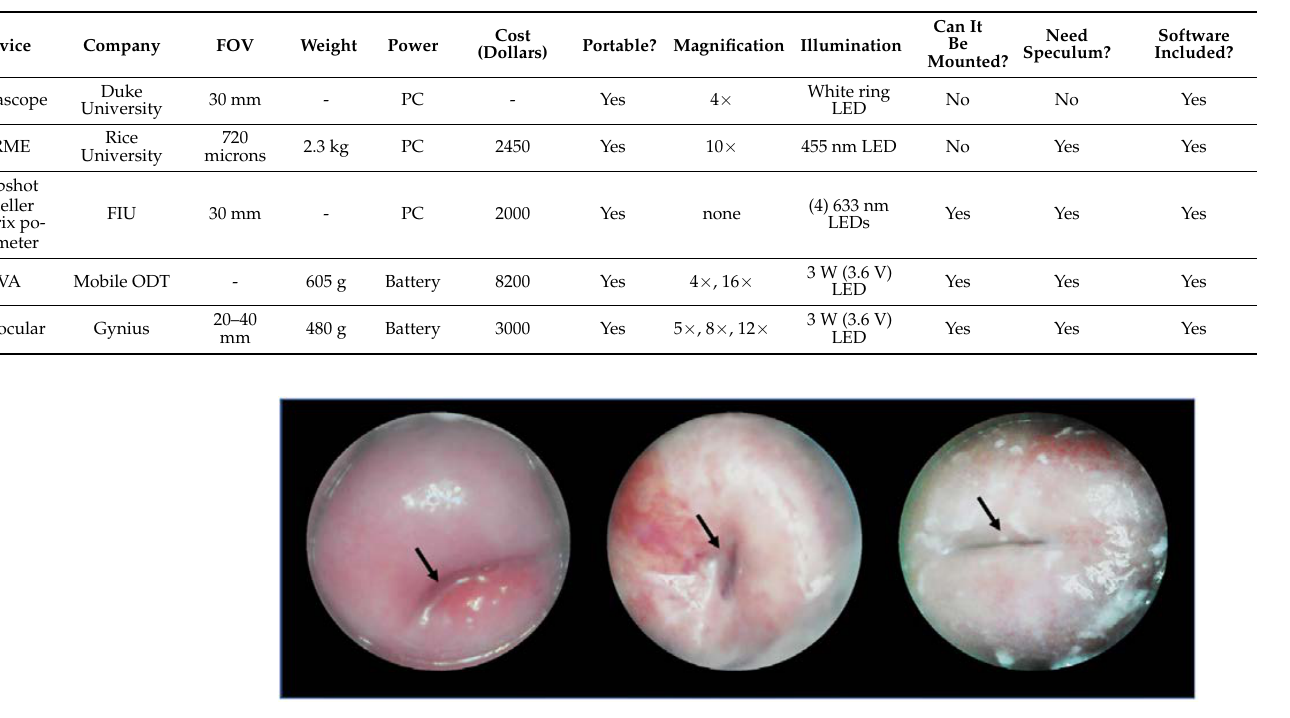
Figure 8. Representative cervix images of ( A , D ) the whole cervix, ( B , E ) the nuclei as seen by the HRME, and the ( C , F ) histopathology. The arrow points to the region of interest being imaged from A and D, shown in images B and E (Reprinted from Ref. [44]).